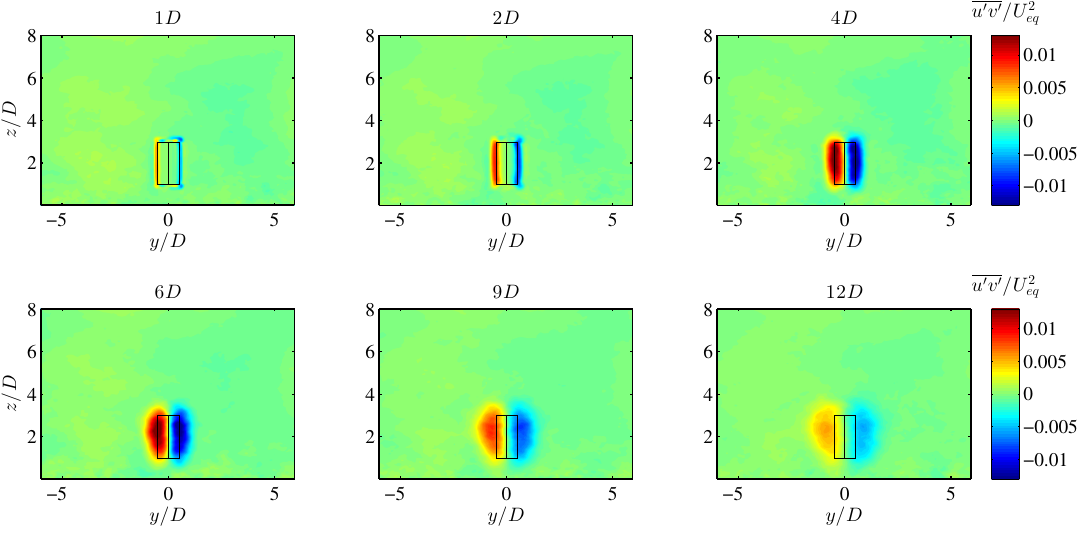
Figure 16. Contour plots of the normalized lateral turbulent flux, u (cid:48) v (cid:48) / U eq 2 , in six different y - z planes at different distances downstream of the center of the turbine.